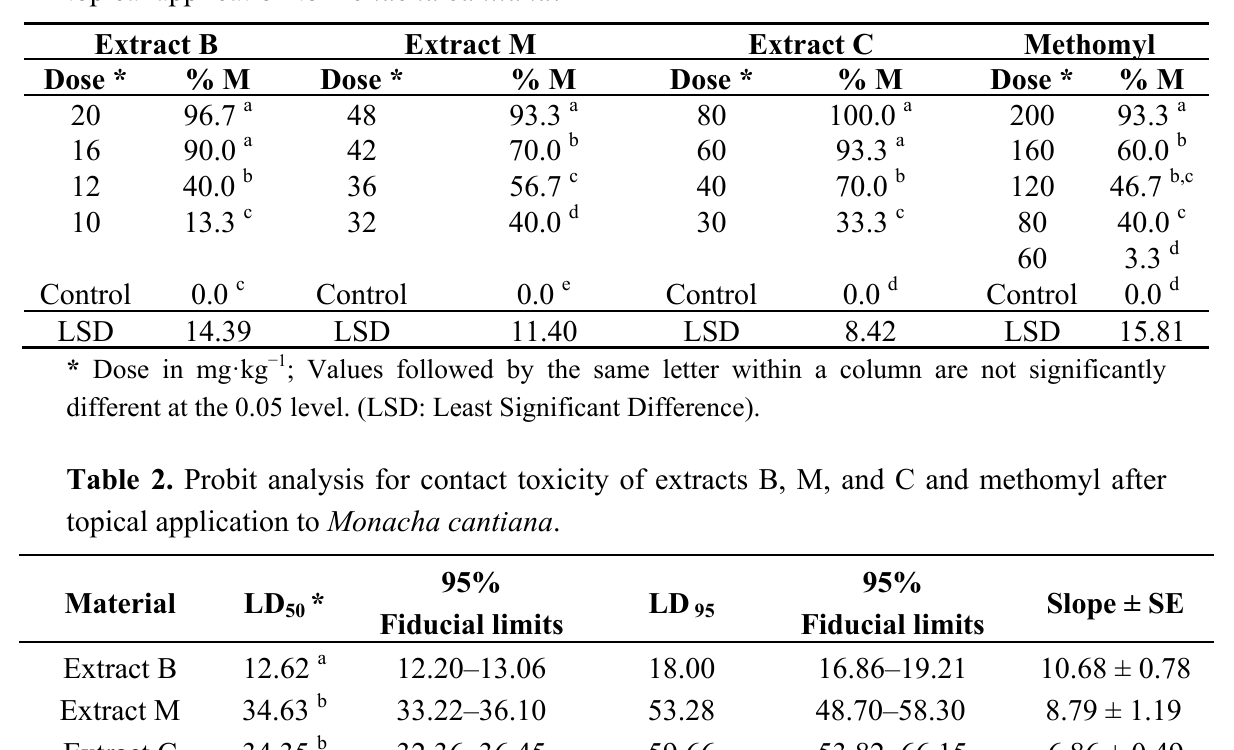
Table 1. Average mortality values (% M) for extracts B, M, and C and methomyl after topical application to Monacha cantiana .